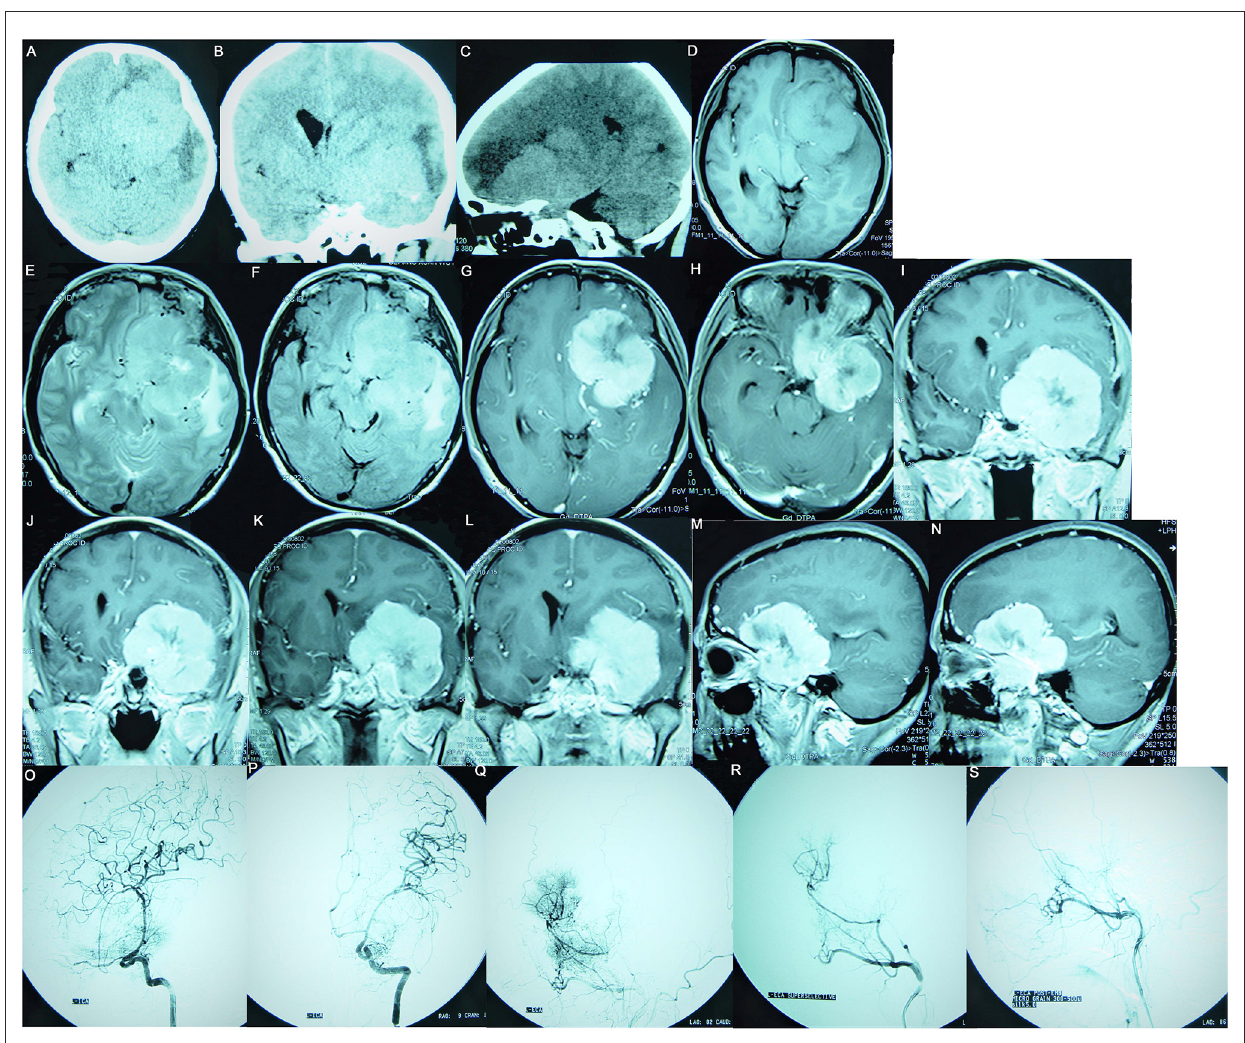
FIGURE1 Preoperative images of a 61-year-old female patient, suggesting a meningioma whose base is rising from the ACP. (A–C) The CT plain scan images show a right parasellar isodense focus accompanied by hyperostosis of the ACP; the focus had a significant mass effect accompanied by left frontal and left temporal cerebral edema. (D) The T1WI image suggests isointensity; (E) The T2WI image suggests hyperintensity surrounded by a significant vascular flow void shadow. (F) The T2/FLAIR image suggests a hyperintense tumor surrounded by significant edema. (G–N) Enhanced MRI suggests that the tumor was significantly enhanced, with clear boundaries, uneven signal intensity, and calcification inside; the tumor encased the ICA and its branches and pushed the left posterior cerebral artery. (G, H) Enhanced axial images show that the tumor was centered around the ACP, growing toward the anterior and central skull base. (I–L) Enhanced coronal images show that the tumor pushed downward to invade the cavernous sinus, moved upward toward the Sylvian fissure, encased the ICA and its branches, and invaded the optic canal. (M, N) Enhanced sagittal images show that the tumor encased the ACP to grow forward and backward. (O–S) Preoperative DSA examination suggests that the tumor had a dual blood supply via the external and internal carotid arteries. (O) The preoperative internal carotid angiography shows the ICA siphon was compressed, the ACP and M1 segment had many newly formed blood vessels involved in the tumor’s blood supply, and the ophthalmic artery was significantly thickened. (P) The entopic image shows that the M1 segment was elongated and thinned and moved upward. (Q) The external carotid arteriography shows